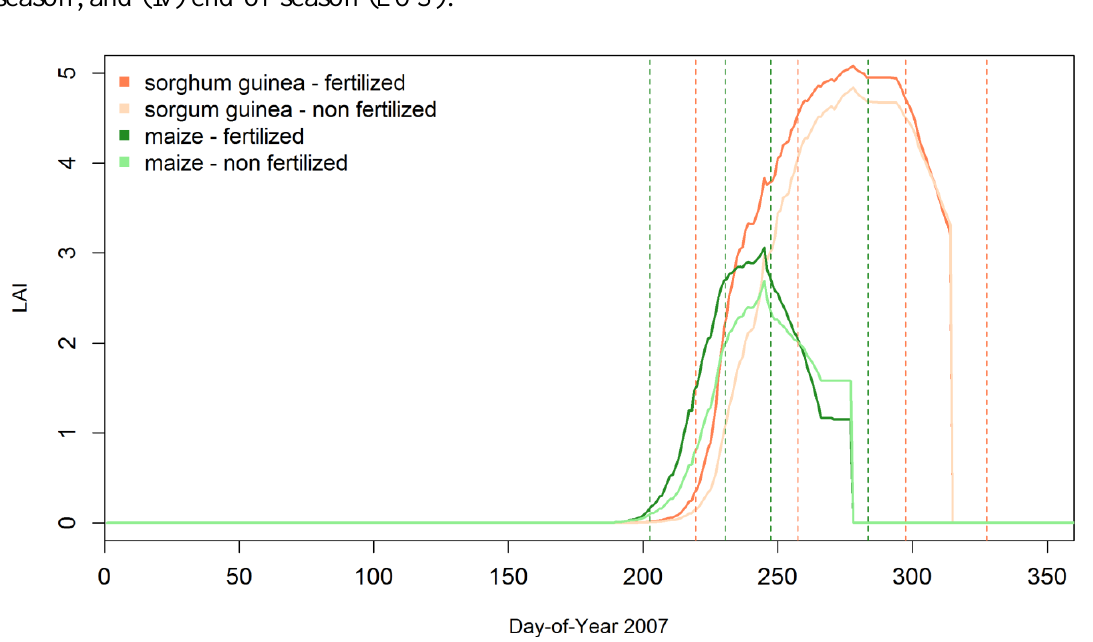
Figure 4. Examples of model-derived phenometrics (dotted lines) calculated with Zhang’s non-linear functions for two sets of LAI simulations using the SARRA-H crop model for the Kita synoptic station in 2007. The green curve represents the maize LAI simulation (fertilized in the dark, non-fertilized in light); the orange curve represents the Guinea Sorghum LAI simulation (fertilized in the dark, non-fertilized in light). For each fertilized curve, the dotted lines correspond to the following from left to right: (i) start-of-season (SOS); (ii) start-of-maximum (SMAX) of season; (iii) end-of-maximum (EMAX) of season; and (iv) end-of-season (EOS).